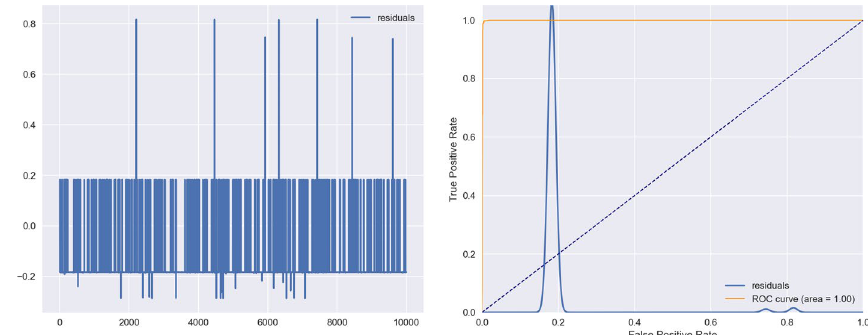
Fig. 5 Results of applying XGBoost to D03 only. Left: residual sequence with original timed order. Right: ROC curve and residual distribution